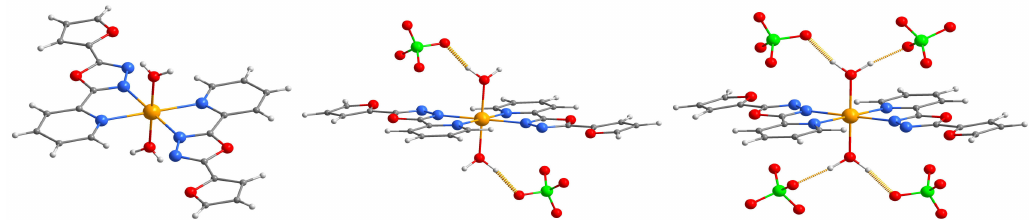
Figure 6. Structures used in calculations of ZFS parameters, molecular fragment [M(fpo) 2 (H 2 O) 2 ] 2 +